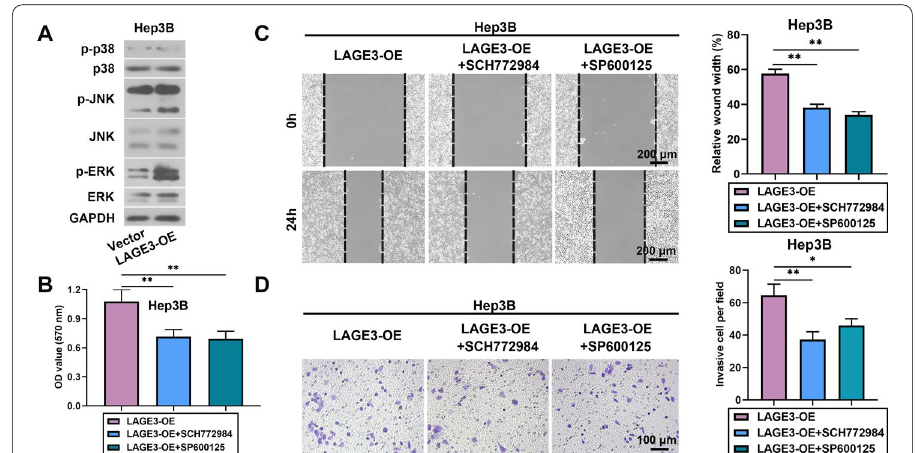
Fig. 6 LAGE3 aggravated HCC progression by enhancing the JNK and ERK signaling pathway. Hep-3B cells were transfected with LAGE3-OE and then incubated with ERK inhibitor SCH772984 or JNK inhibitor SP600125. A Western blot bands of p-p38, p38, p-JNK, JNK, p-ERK, and ERK in Hep3B cells. B Proliferation ability of Hep3B cells. C – D Migration and invasion abilities of Hep3B cells. Data are shown as mean deviation. *p < 0.05, **p <